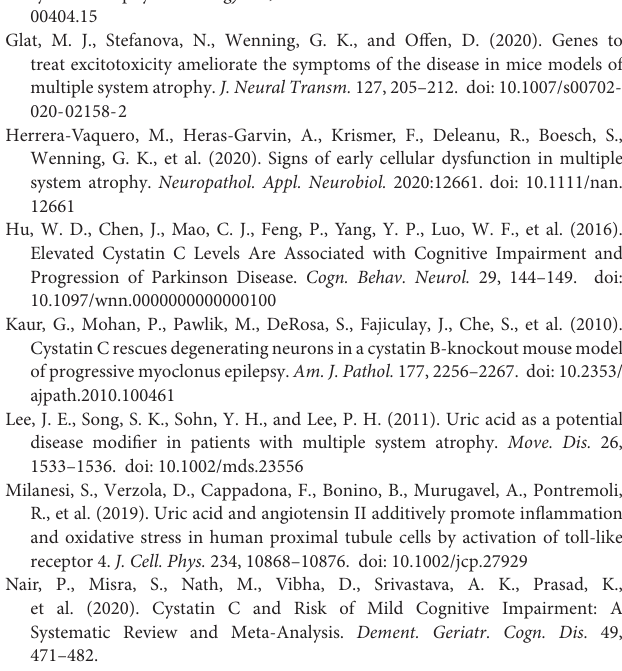
Supplementary Figure 1 | Serum oxidative biomarkers in different MSA subgroups. (A) There was no significant difference in the serum levels of UA when compared between patients with MSA-C and MSA-P (305.82 ± 72.89 vs. 348.04 ± 93.56, p = 0.074). (B) There was no significant difference in the serum levels of BUN when compared between patients with MSA-C and MSA-P (5.44 ± 1.81 vs. 5.95 ± 1.49, p = 0.280). (C) There was no significant difference in the serum levels of Cys-C when compared between patients with MSA-C and MSA-P (0.92 ± 0.14 vs. 1.00 ± 0.16, p =